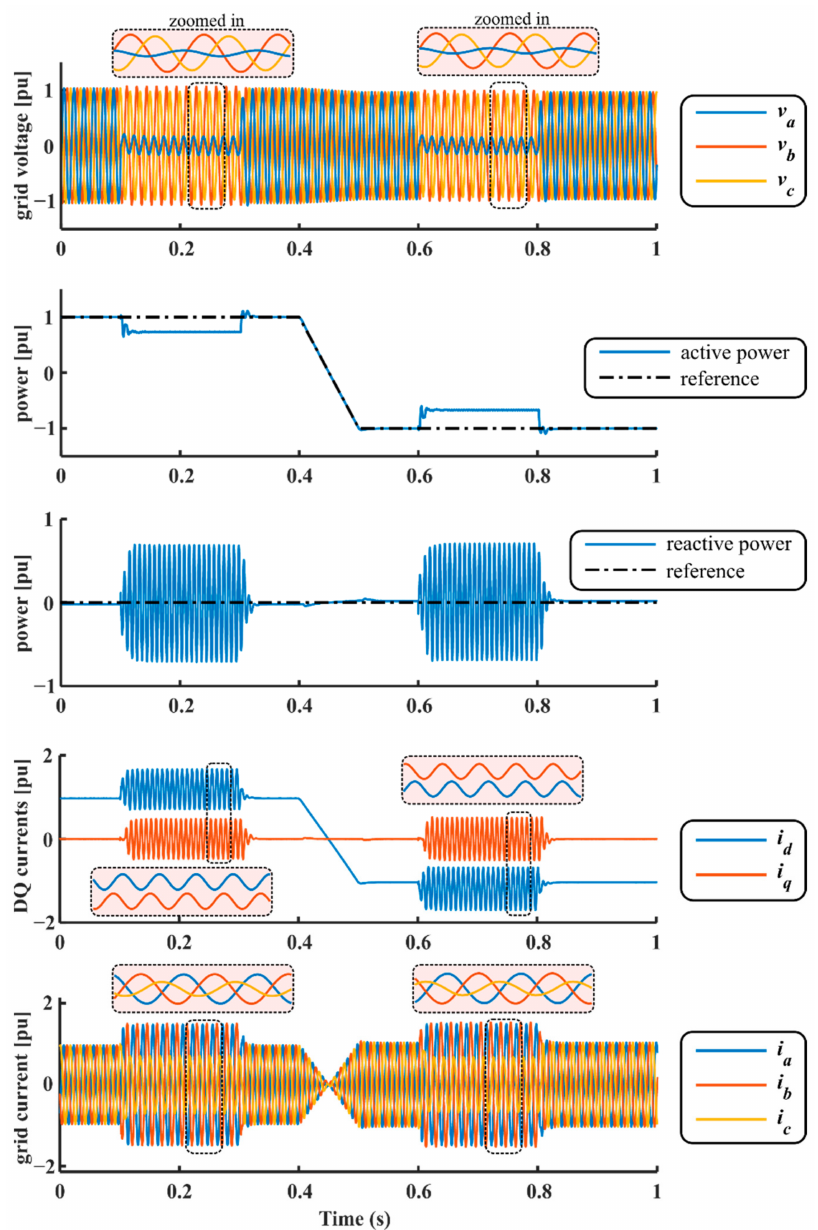
Figure 17. Dynamic performance of the MMC with the proposed feedback control method under SLG